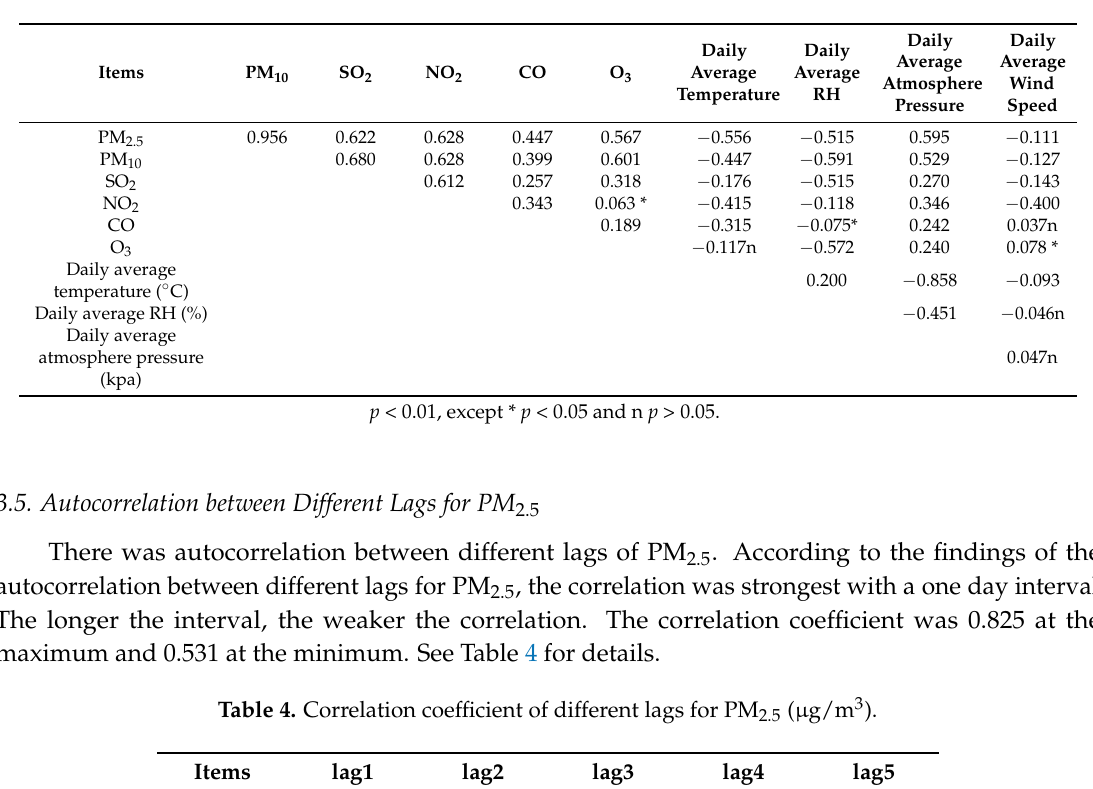
Table 3. Spearman correlation analysis of air pollutants and meteorological factors in Shenzhen during 2013–2015 (r value).